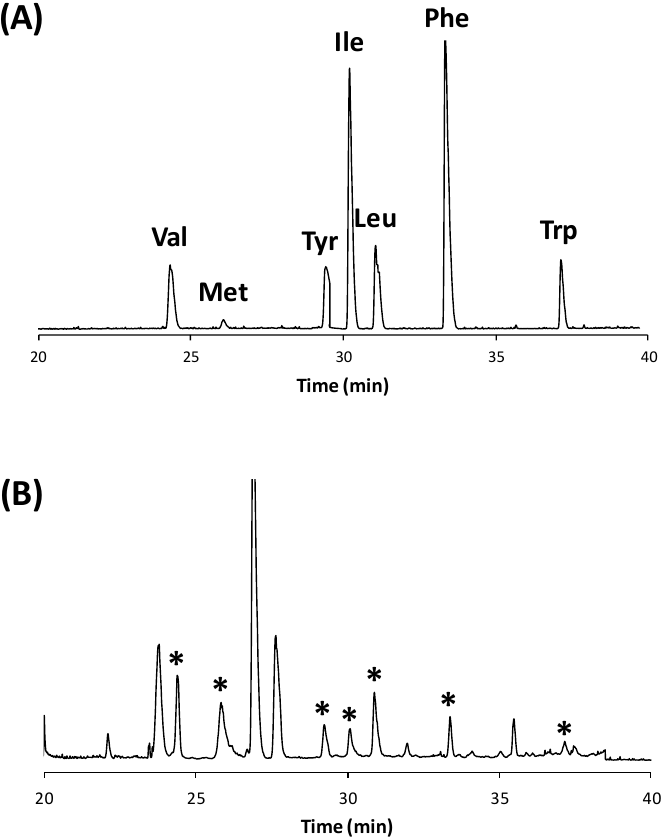
Figure 1. IP-RP-HPLC-ELSD analysis of ( A ) a pool of standard amino acids and ( B ) of the extract. Experimental conditions: column, Prevail RP18 column (Grace, Sedriano, Italy); mobile phase, eluent A (7.0 mM HFBA in water) and eluent B (net MeCN); gradient, 0–10 min, 100% A; 10–30 min, linear gradient to 75% A; 30–38 min, linear gradient to 70% A; 38–39 min, gradient back to 100% A; 39–65 min, 100% A; flow rate, 0.7 mL/min; column temperature, 25 ◦ C; ELSD setting, Tneb 30 ◦ C, Tvap 50 ◦ C, gas flow rate 1 L/min, gain 1. Asterisks in ( B ) refer to the identified amino acids as indicated in ( A